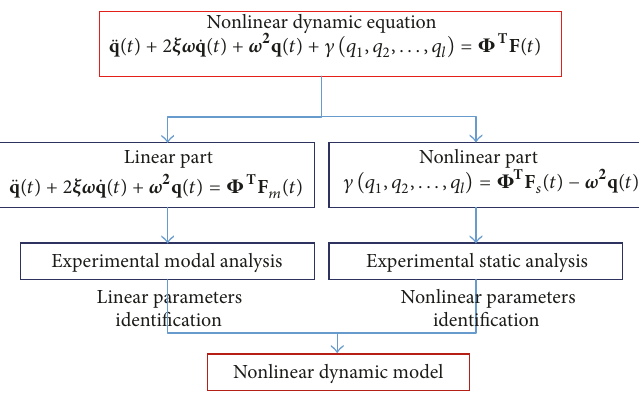
Figure 1: The flowchart of the numerical-experimental method.